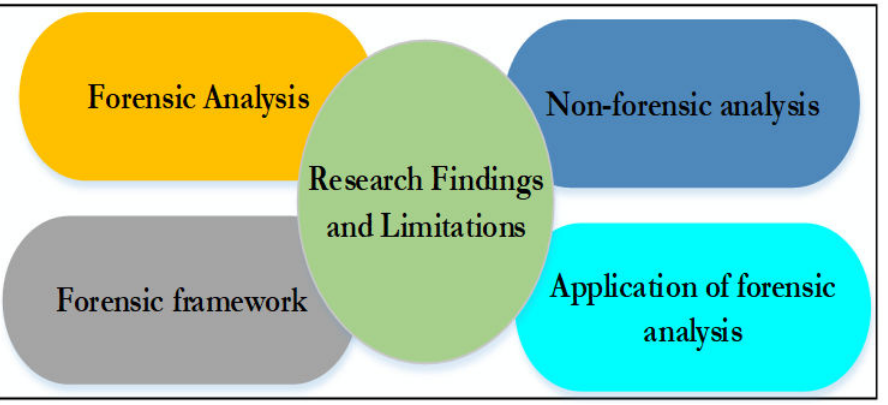
Figure 3. Thematic Depiction of the Drone Forensics